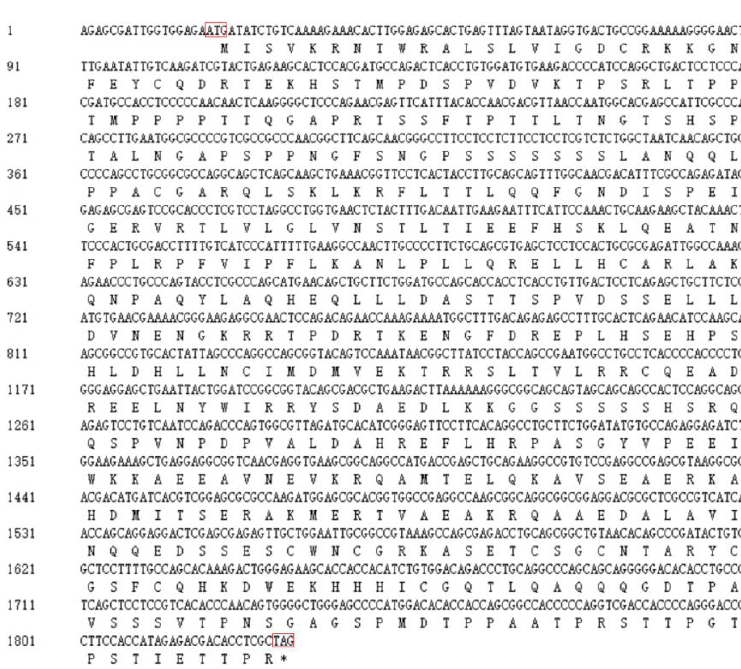
Figure 2. The cDNA fragment and predicted protein sequences of ovine RUNX1T1. The start and stop codons are framed in red. The protein sequence was predicted by the BLAST tool of DNAMAN (version 6.0, LynnonBiosoft, San Ramon, CA, USA) and is presented under the coding sequence. All sequences were aligned by the DNAMAN (version 6.0, LynnonBiosoft) software. * means the translation is terminated.